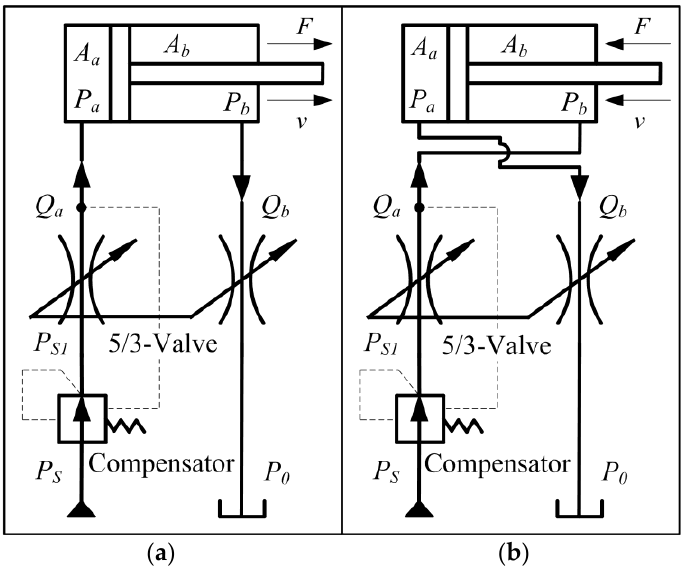
Figure 11. Simplified schematic of conventional load sensing system (CLSS) with two working modes. ( a ) Extension working mode, ( b ) retraction working mode.